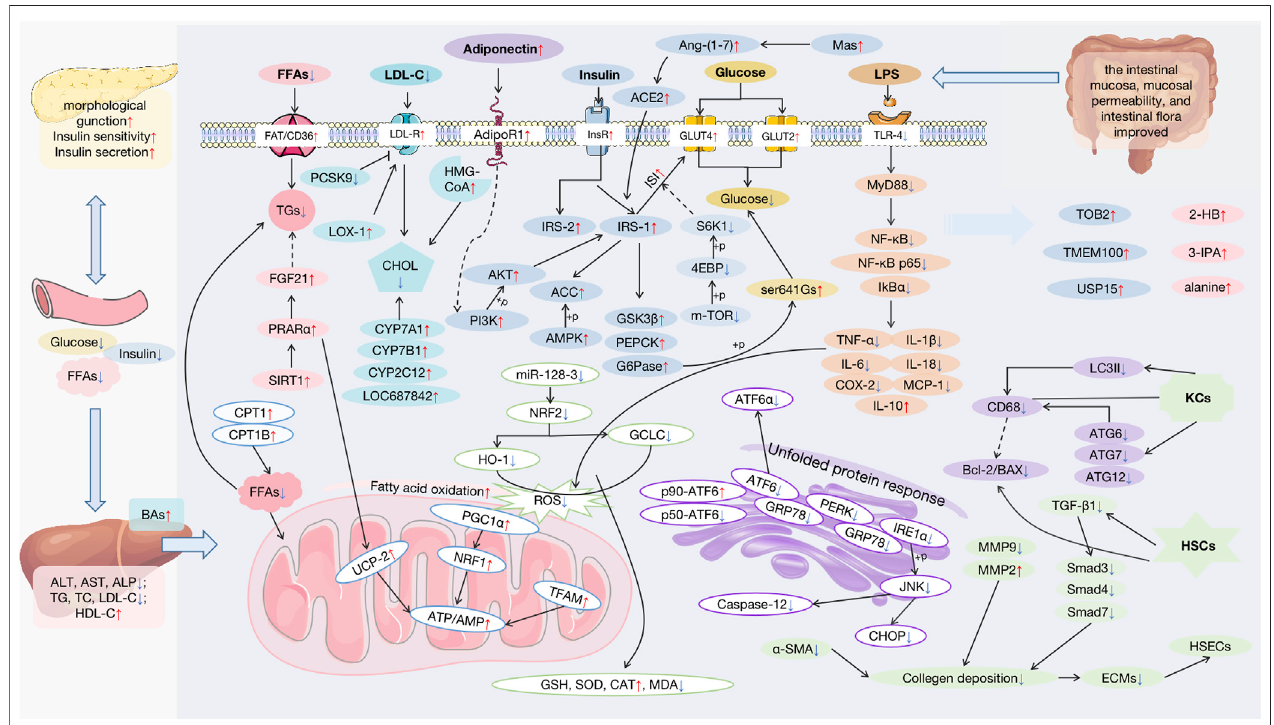
FIGURE 3 | Pharmacological effects and molecular mechanisms of APS against NAFLD. FFAs: free fatty acids; AST: aspartate transaminase; ALT: alanine aminotransferase; ALP: alkaline phosphatase; TG: triglyceride; TC: total cholesterol; LDL-C: low-density lipoprotein cholesterol; HDL-C: high-density lipoprotein cholesterol; BAs: bile acids; FGF21: fi broblast growth factor 21; PPAR α : peroxisome proliferator-activated receptor alpha; SIRT1: stimulating the sirtuin 1; CPT1: carnitine palmitoyltransferase 1; LDL-R: low-density lipoprotein receptor; PCSK9: proprotein convertase subtilisin/kexin type; LOX-1: oxidized-LDL receptor-1; CHOL: cholesterol; CYP: cholesterol hydroxylase; HMG-CoA: 3-hydroxy-3-methyl glutaryl coenzyme A reductase; InsR: insulin receptor; Ang-(1 – 7): angiotensin-(1 – 7); ACE2: angiotensin-converting enzyme 2; IRS: insulin receptor substrates; ACC: acetyl-CoA carboxylase; AMPK: AMP-activated protein kinase; AKT: protein kinase B; PI3K: the phosphatidylinositol-3 kinase; GSK3 β : the glycogen synthase kinase 3beta; PEPCK: the phosphoenolpyruvate carboxyl kinase; G6Pase: the gluconeogenic enzymes glucose 6-phosphatase; S6K1: S6 kinase 1; 4EBP: 4E-binding protein; GRP78: glucose-regulated protein 78; ATF6: transcription factor 6; PERK: protein kinase-like endoplasmic reticulum kinase; IRE1 α : inositol-requiring enzyme1; JNK: the c-Jun N-terminal kinase; CHOP: C/EBP-homologousprotein; NRF1: thenuclear factor erythroid 2-like 1; HO-1: heme Oxygenase-1; GCLC: glutamate-cysteine ligase; ROS: reactive oxygen species; PGC1 α : the peroxisome proliferator-activated receptor γ coactivator 1; NRF2:; nuclear erythroid-derived 2-related factor 2; UCP-2: uncoupling protein 2; TFAM: the mitochondrial transcription factor A; GSH: glutathione; SOD: superoxide dismutase; CAT: peroxidase catalase; MDA: malondialdehyde; LPS: lipopolysaccharide; TLR4: toll-like receptor 4; MyD88: the adaptor protein myeloid differentiation primary response 88; NF- κ B: the nuclear factor-kappa B; IkB α : inhibitory kappa B alpha; TNF- α : tumor necrosis factor-alpha; IL-1 β : interleaukin-1 β ; IL-6: interleaukin-6; IL-18: interleaukin-18; COX-2: cyclooxygenase-2; MCP-1: monocyte chemoattractant protein-1; IL-10: interleaukin-10; LC3II: protein Ⅱ light chain 3; ATG: recombinant autophagy-related protein; KCs:; HSCs: hepatic stellate cells; HSECs: hepatic sinusoidal endothelial cells; TGF- β 1: transforming growth factor- β 1; ECM: extracellular matrix; TOB2: transducer of ErbB2.2; USP15: the ubiquitin-speci fi c proteases 15; 2-HB: 2-hemoglobin; 3-IPA: 3- indolepropionic